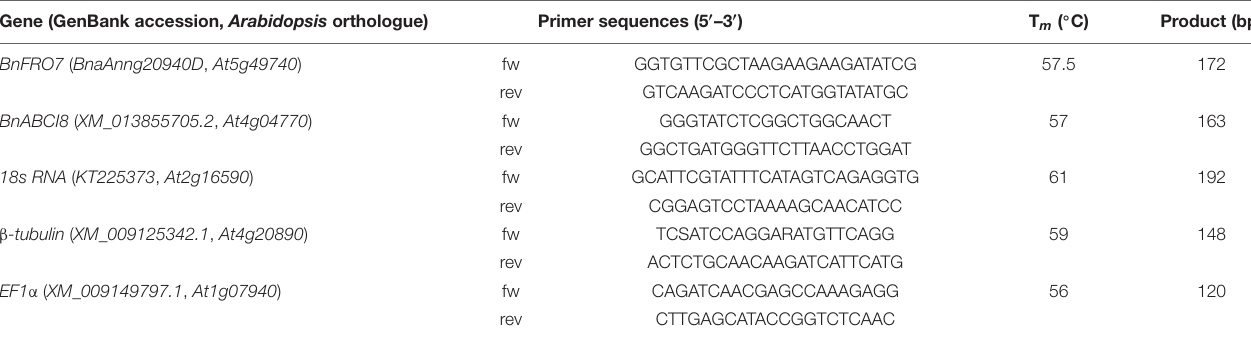
TABLE 1 | Oligonucleotide primers used in the expression analysis. Gene (GenBank accession, Arabidopsis orthologue) Primer sequences (5 (cid:48) –3 (cid:48)